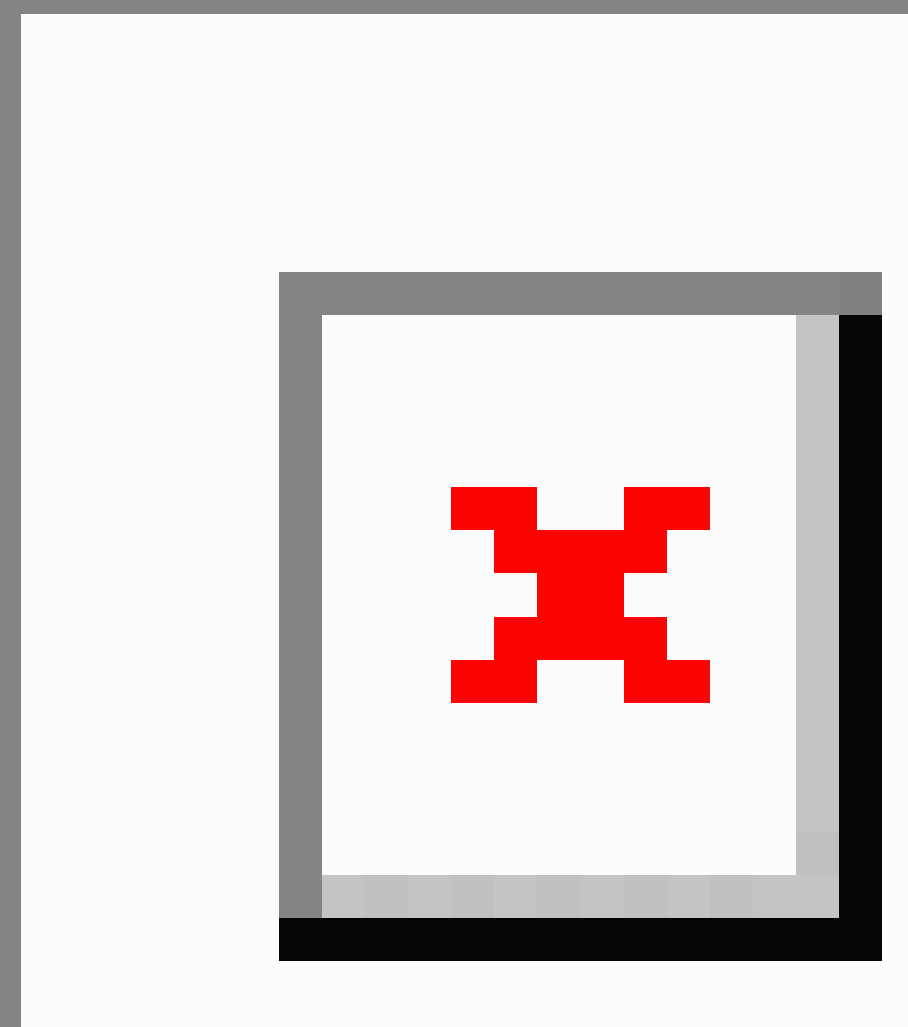
Figure 2. Repeated application of nine missing data approaches